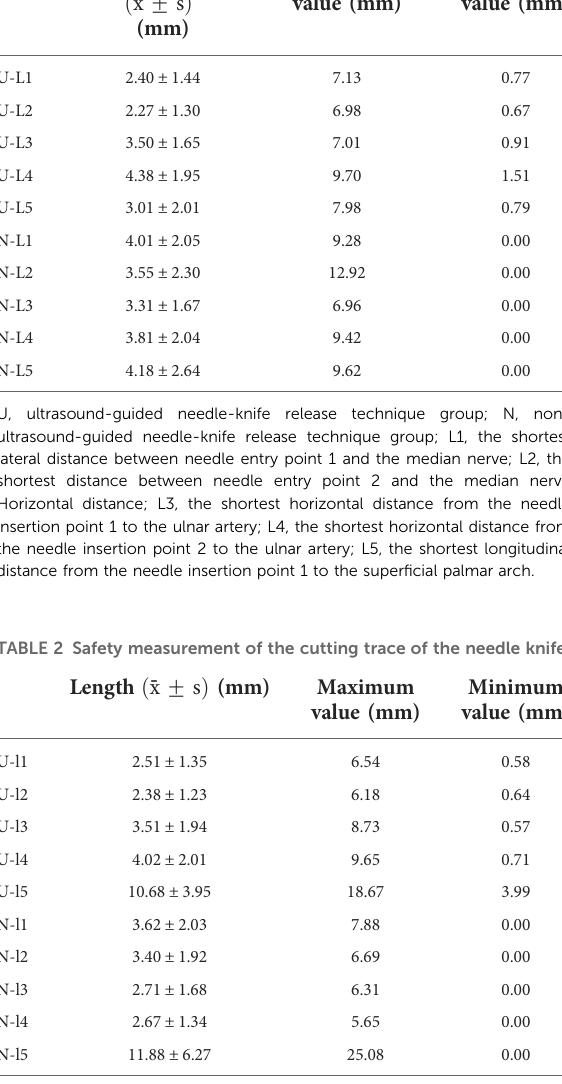
between the cutting trace of needle insertion point 1 and the median nerve; l2, the cutting of needle insertion point 2 The shortest lateral distance between the trace and the median nerve; l3, the shortest lateral distance from the cutting trace of needle entry point 1 to the ulnar artery; l4, the shortest lateral distance from the cutting trace of needle entry point 2 to the ulnar artery; l5, the shortest lateral distance from needle entry point 2 The shortest longitudinal distance between the tip of the needle and the shallow arch of the